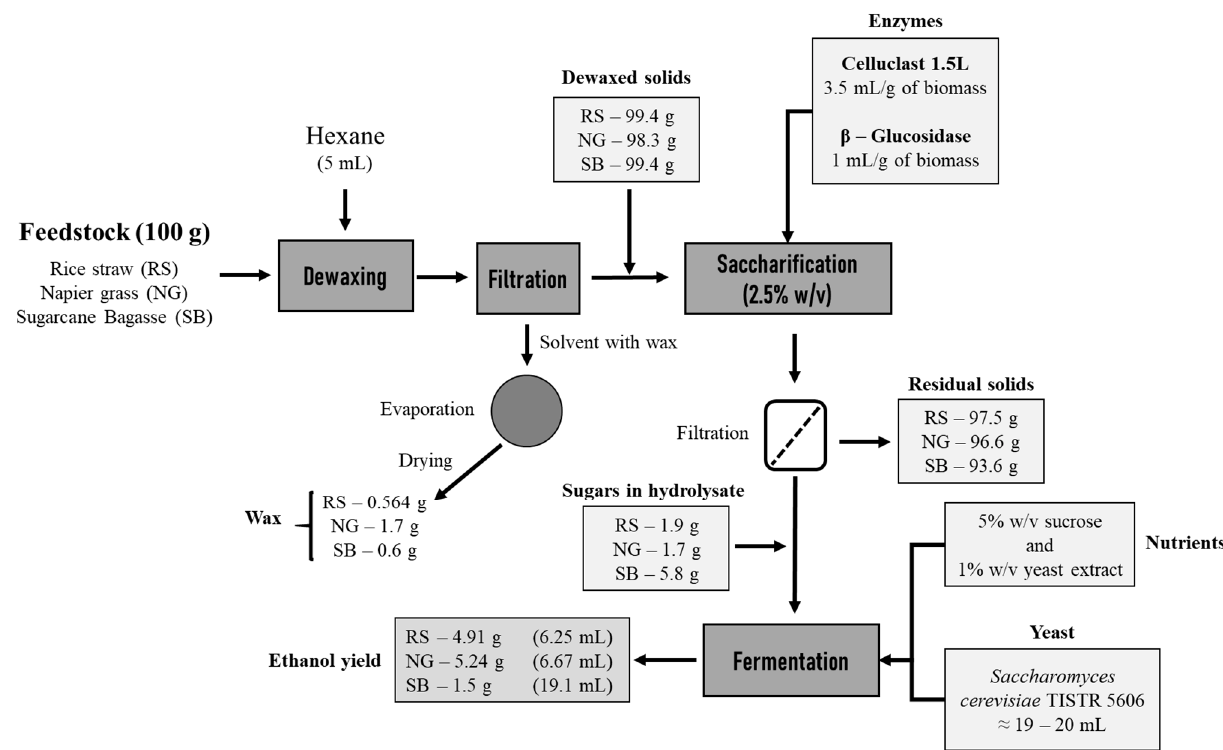
Figure 8. Material balance for ethanol and wax yields from dewaxed solids.